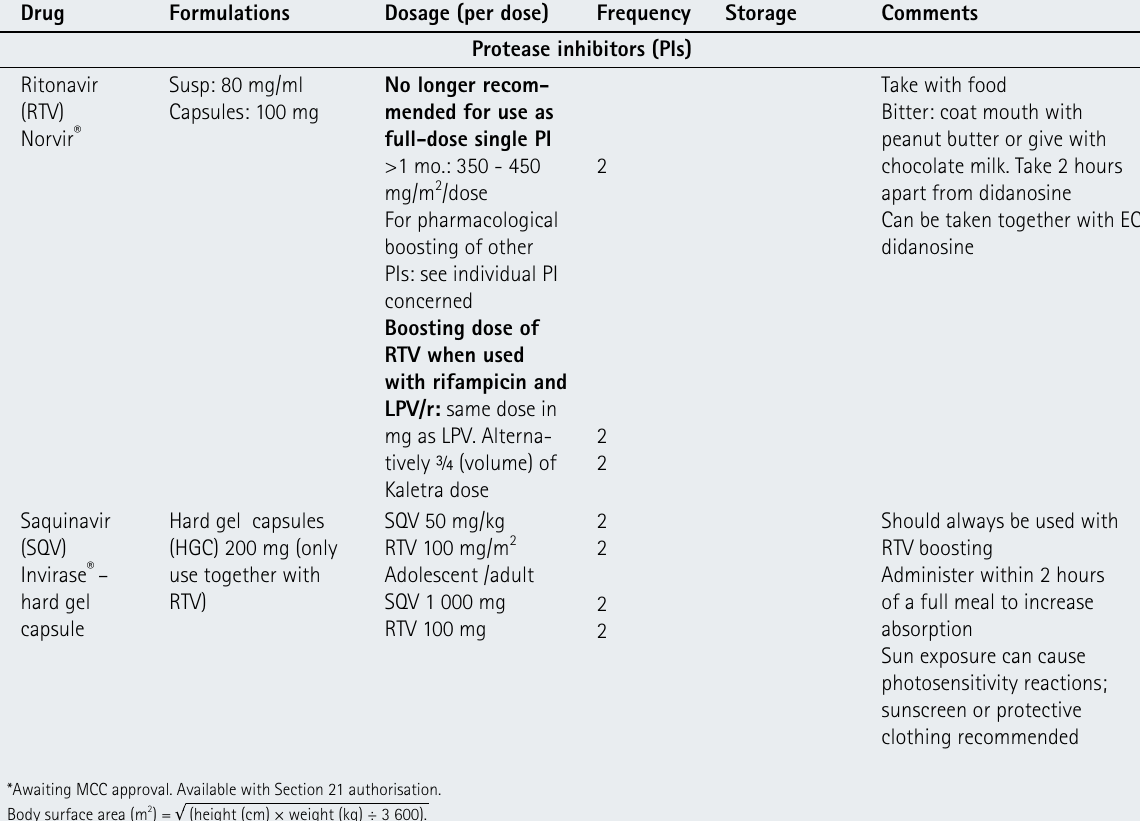
TABLE V. DOSAGE AND FREQUENCY OF ARVs IN CHILDREN